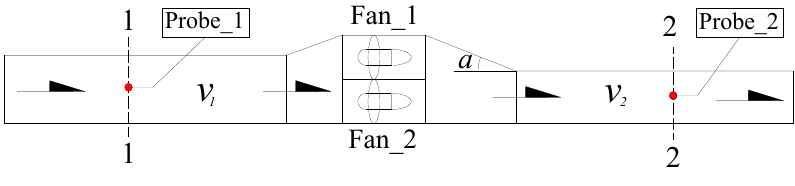
Figure 1. Description of parallel fan station (PFS).